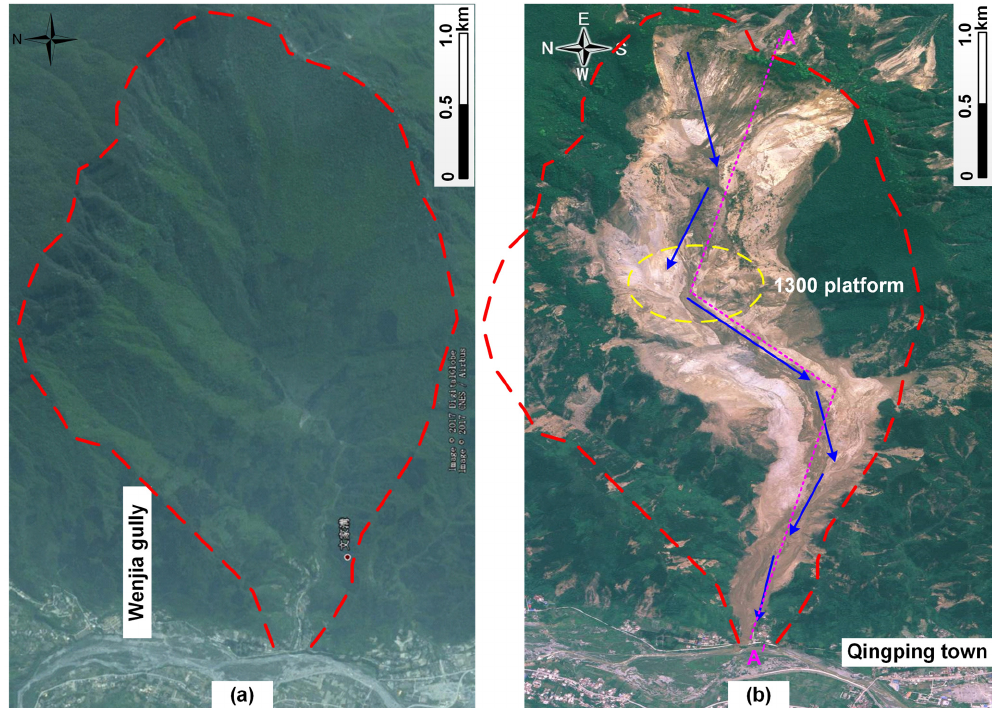
Figure 3. Aerial image of Wenjia gully (a) image from Google Earth on 31 December 2007; (b) aerial photograph taken on 18 May